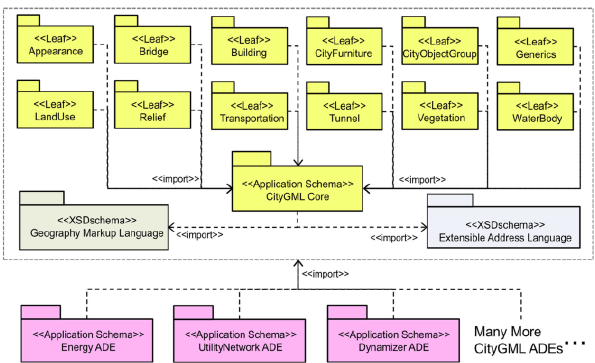
Figure 1. UML package diagram illustrating the separate modules of CityGML and their schema dependencies. (Source: OGC CityGML Encoding Standard,